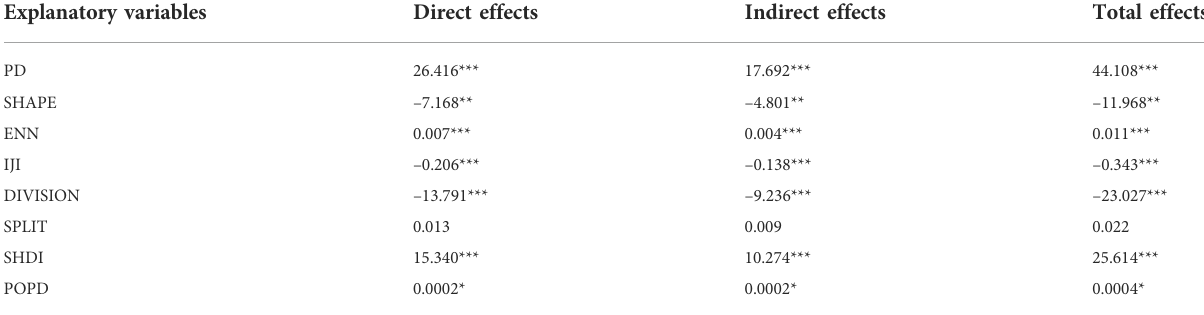
TABLE 3 Direct and indirect effects of explanatory variables on the ESBI quanti fi ed using the SDM. Explanatory